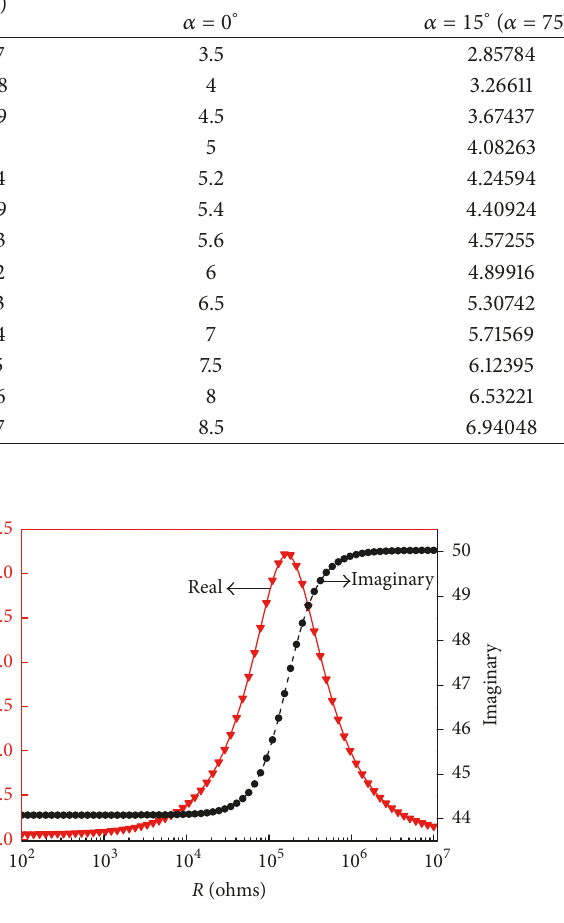
Figure 3: Real and imaginary parts of the circuit conjugate solu- tions.